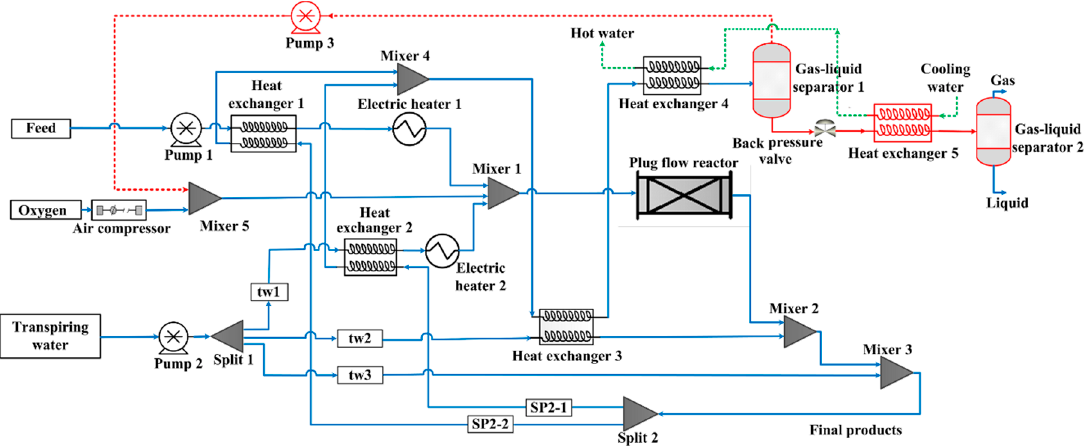
Figure 9. The Aspen Plus diagram of supercritical water oxidation system with oxygen recovery (lines and equipment with red color are specially for OR).